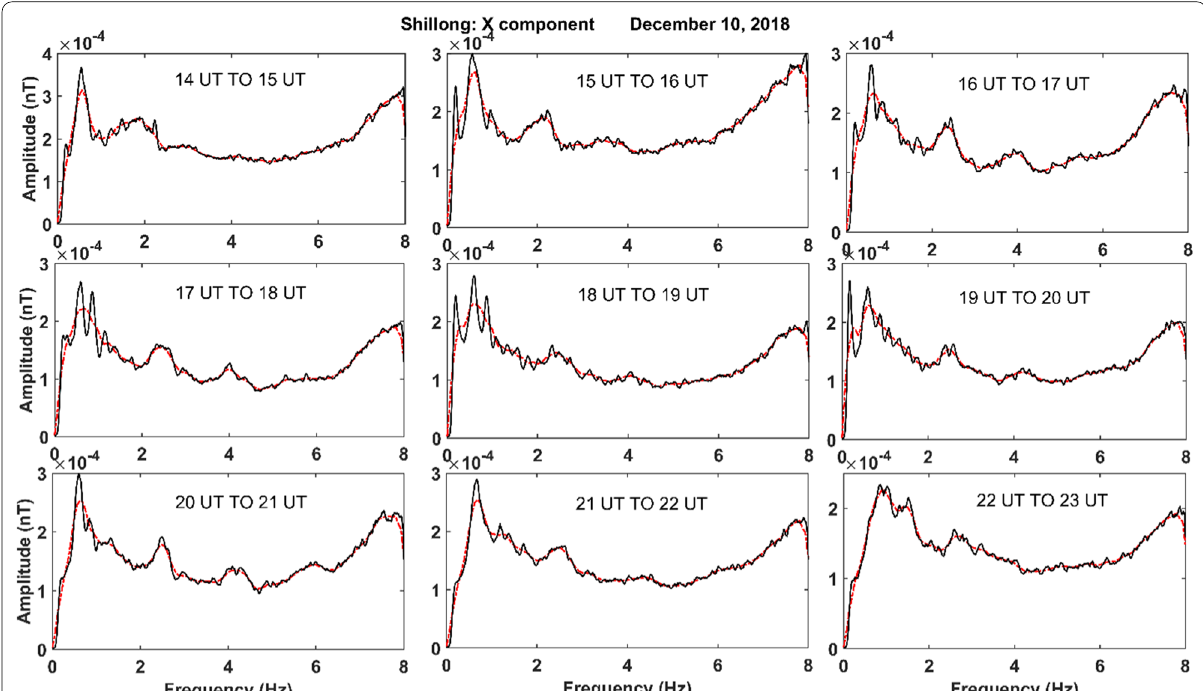
Fig. 5 Hourly static power spectra of B x component showing the frequency separation for both small and large Spectral Resonance Structures. The solid black line is the power spectra with frequency resolution of 0.0156 Hz and dashed red line denotes the frequency resolution of 0.0625 Hz